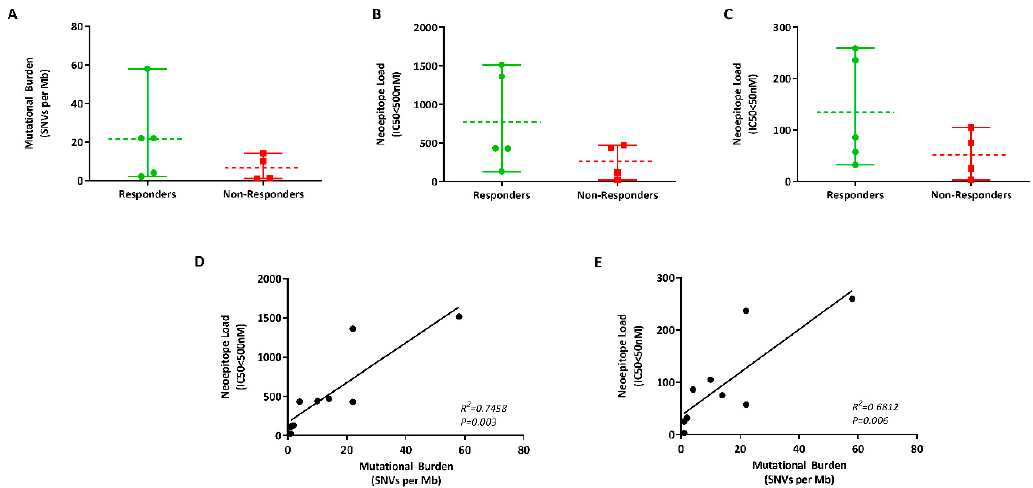
Figure 4. ctDNA as a tumour source for mutational burden analysis. ( A ) Vertical scatter plot of the difference in the mutational burden (number of single-nucleotide variants (SNVs per Mb of DNA) in responders (green) and non-responders (red) to anti-PD-1 blockade. Graphs indicating the difference in the number of low—IC50 < 500 nM ( B ) and high—IC50 < 50 nM ( C ) affinity neoantigens in melanoma patients treated with immunotherapy. Correlation between the mutational burden and neoepitope loads at IC50 < 500 nM ( D ) and IC50 < 50 nM ( E ).